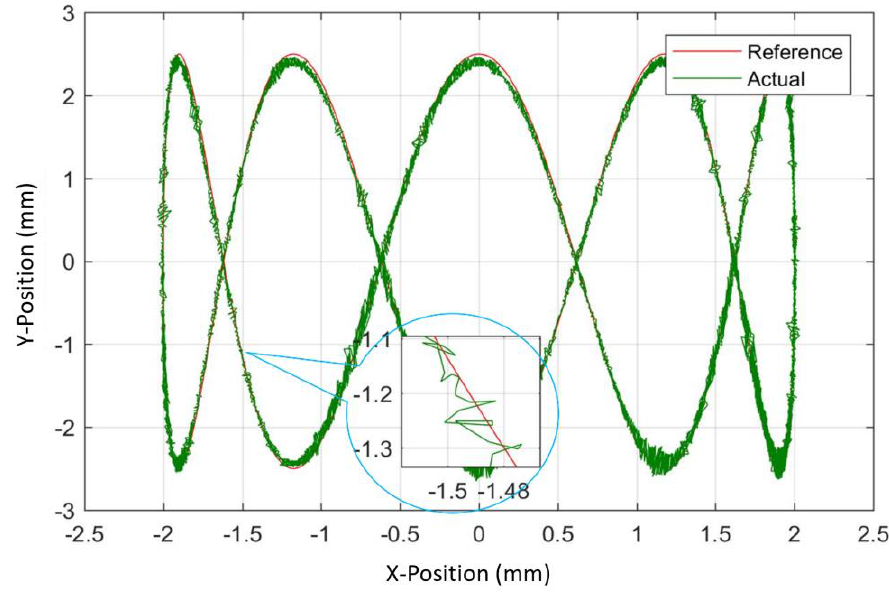
Figure 24. Experimental demonstration for tracking a Lissajous path.